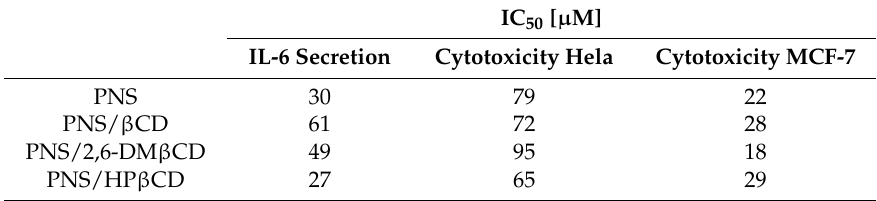
Table 3. The effect of pinostrobin and its complexes on the secretion of the pro-inflammatory